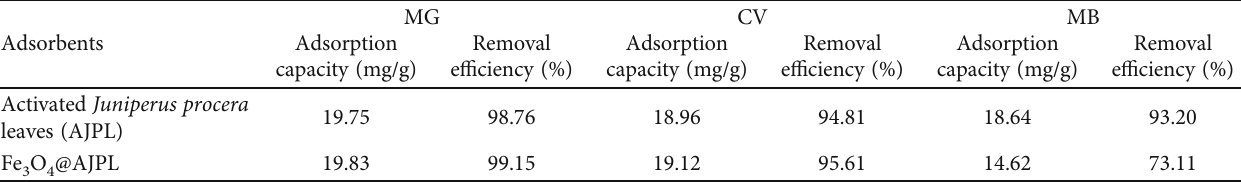
O @AJPAL — 50 mg, 3 4